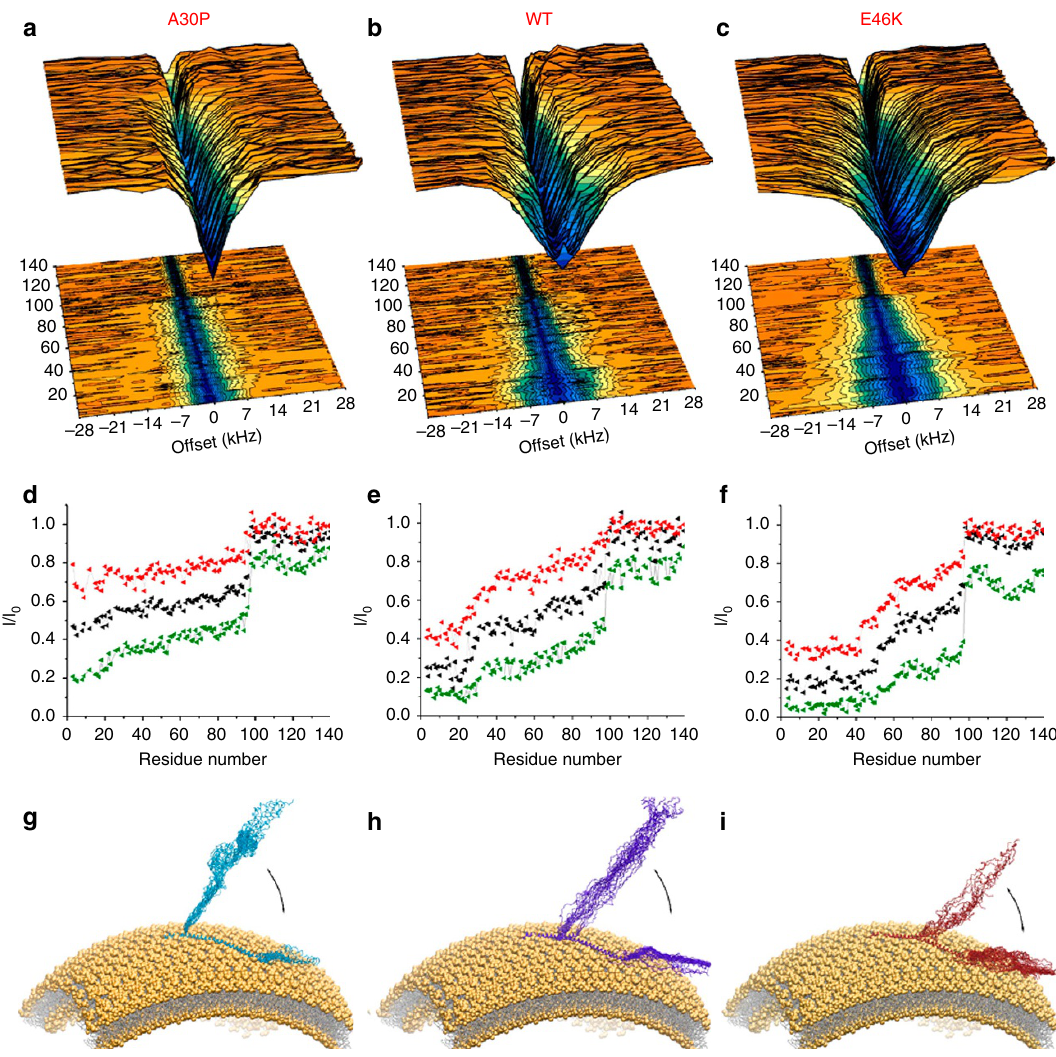
Figure 1 | CESTexperiments probing the membrane interactions of a S A30P and a S E46K . CESTexperiments were recorded at a 1 H frequency of 700 MHz (see Methods section), using protein concentrations of 300 m M and 0.06% (0.6mgml (cid:2) 1 ) of DOPE:DOPS:DOPC lipids in a ratio of 5:3:2 and assembled into SUVs. 1 H– 15 N HSQC spectra were recorded by using continuous wave saturation (170Hz or 350Hz) in the 15 N channel at offsets ranging between (cid:2) 28kHz and þ 28kHz; an additional spectrum, saturated at (cid:2) 100kHz, was recorded as a reference. Data recorded using a saturation bandwidth of 350Hz are shown here (the data measured using a saturation bandwidth of 170Hz are shown in Supplementary Fig. 2). For comparison, the plots in panels b and e are drawn using a S WT data from our previous investigation 28 . ( a – c ) CESTsurfaces for a S A30P ( a ) a S WT 28 ( b ) and a S E46K ( c ). ( d – f )